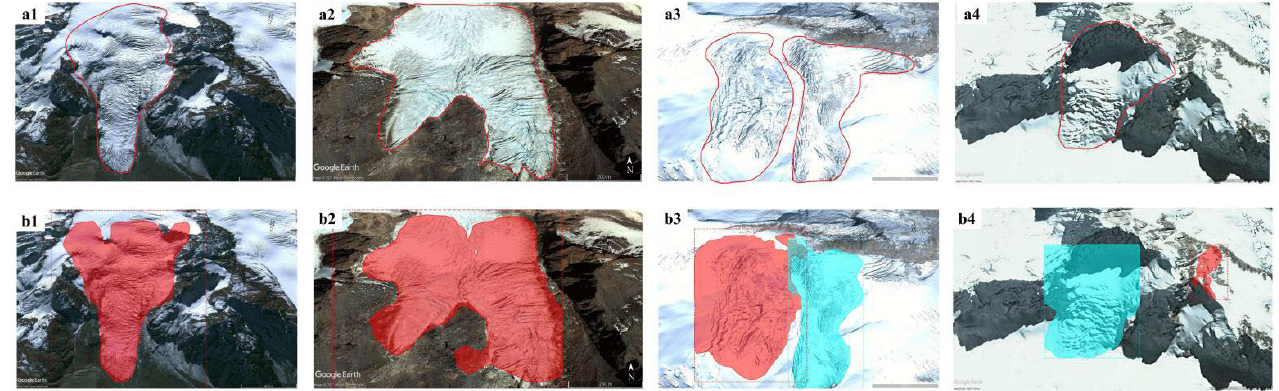
Figure 13. Ice avalanche detection results. ( a1 – a3 ) represents different ice avalanches, and ( b1 – b4 ) are the results of our model.